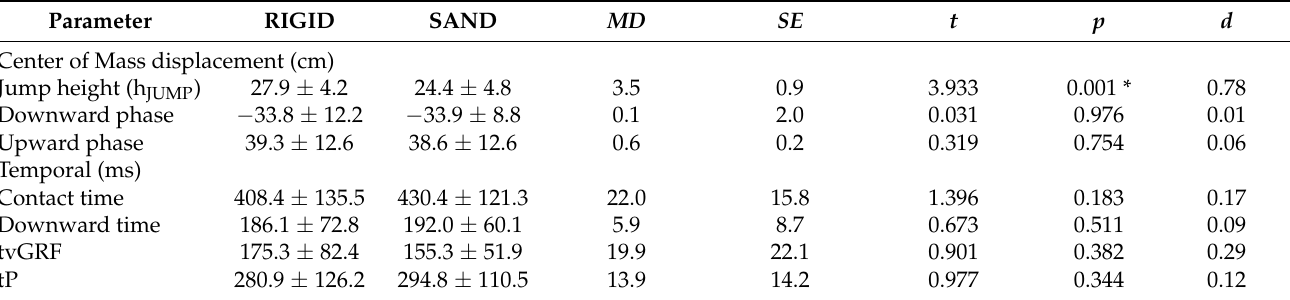
Table 1. Means ± standard deviations of the comparison for the spatiotemporal parameters of the drop jumps on RIGID and SAND surface ( n =